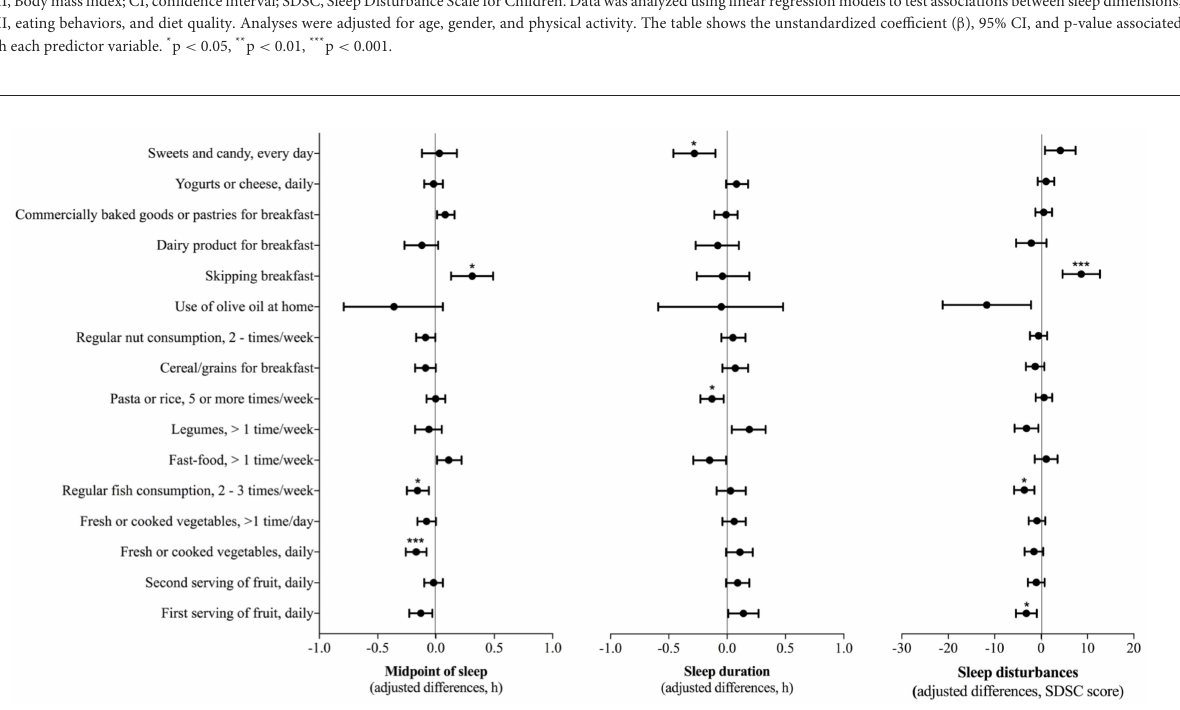
FIGURE1 Associations between sleep dimensions and the 16 items of the Mediterranean Diet Quality Index. General linear models adjusted for age, gender, and physical activity were conducted to test these associations. The figure shows the unstandardized coefficient ( β ), 95% CI, and adjusted p -values associated with each predictor variable. P -values were corrected using the Benjamini–Hochberg method, assuming a False Discovery Rate (FDR) of 5%. * p < 0.05, *** p <